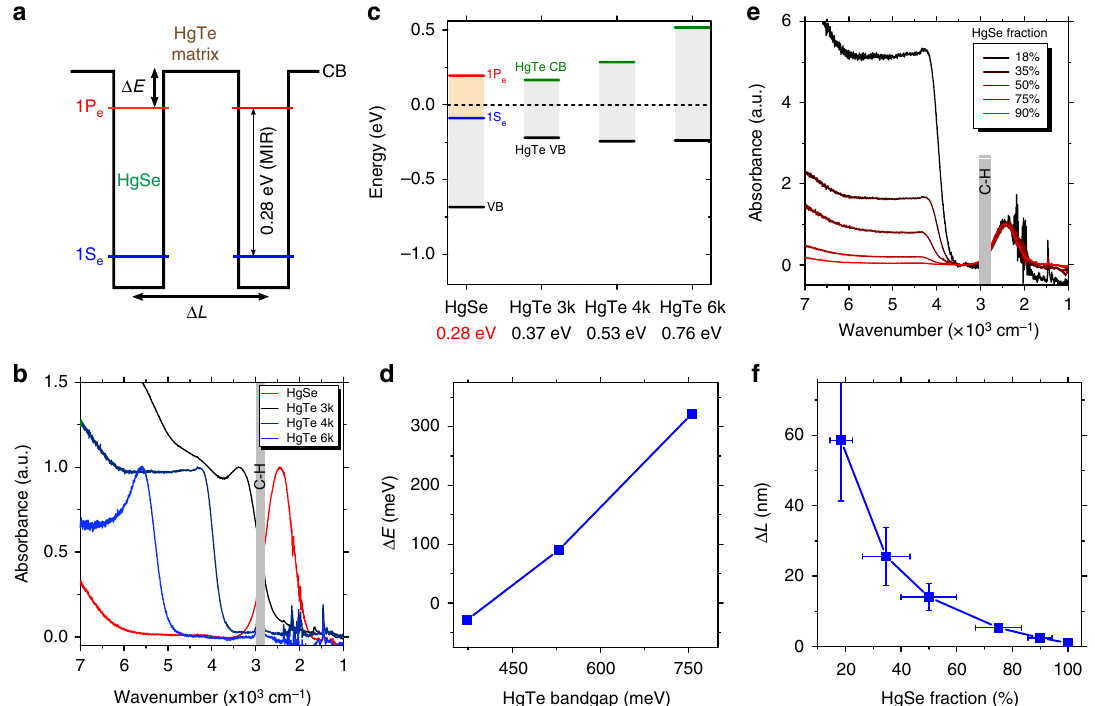
Fig. 2 Design of the energy landscape of a colloidal quantum dot infrared photodetector (CQDIP). a Scheme of the band structure of a CQDIP showing two mid-infrared intraband HgSe nanocrystals (NCs) embedded in a HgTe NC matrix. Important CQDIP structure parameters are highlighted in bold: the energy difference between HgSe 1P e levels and HgTe conduction band (CB), as well as the average distance between two HgSe wells. b Infrared absorbance spectra of the four materials used for this study: HgSe NCs; HgTe NCs with band-edge at 3000 cm − 1 (HgTe 3k); HgTe NCs with band-edge at 4000 cm − 1 (HgTe 4k), and HgTe NCs with band-edge at 6000 cm − 1 (HgTe 6k). c Electronic spectra of the four materials used for this study, determined using a combination of X-ray photoelectron spectroscopic measurements and optical spectroscopy. Bandgap of each material is given in the x axis ð HgTe Þ (cid:3) E ð HgSe Þ between HgSe 1P (intrabandgap is given for HgSe). Black dashed line is the Fermi level. d Energy difference Δ E ¼ E e level and HgTe 1 P e CB CB as a function of the HgTe NC bandgap, extracted from c . e Infrared absorption spectra of HgSe/HgTe 4k NC solutions. Fractions relates to the proportion of HgSe particles in the mix. f Estimation of the average distance Δ L between two HgSe NCs for a given HgSe fraction, assuming a close-packing organization. Horizontal error bars are determined using the error of NC size from transmission electron microscopy and determining the impact of these fl uctuations of the HgSe/HgTe ratio. Vertical error bars are determined using the HgSe fraction